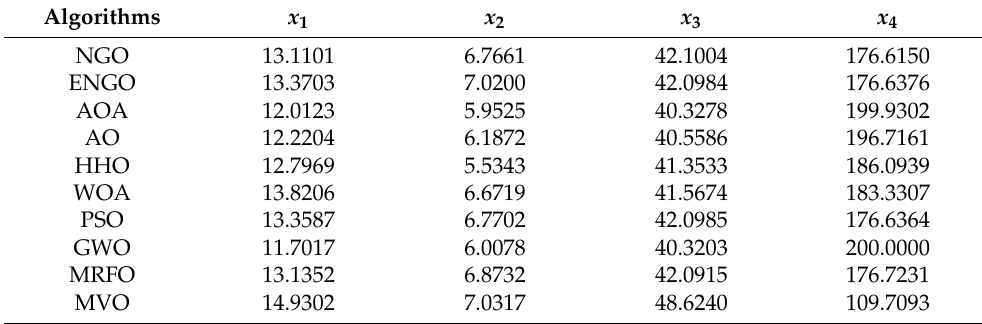
Table 7. The best solution of the pressure vessel design problem obtained by the different algorithms.